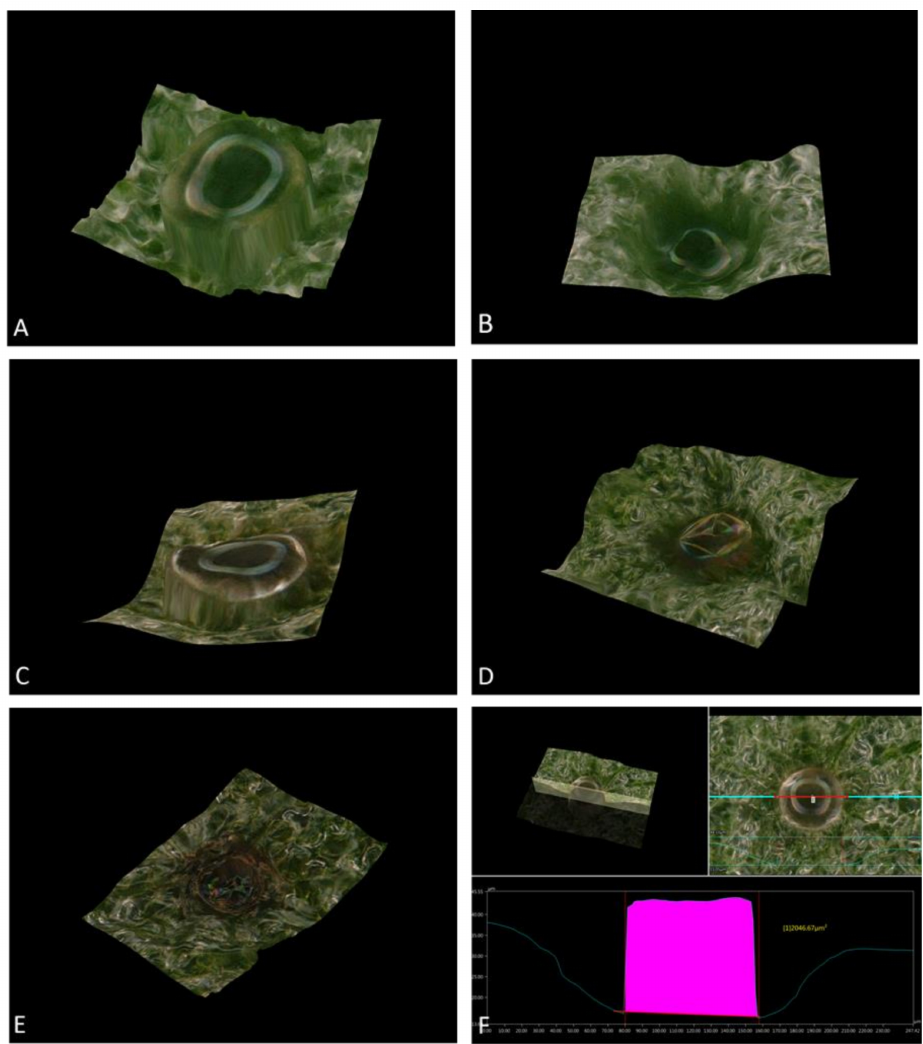
Figure 8. Representative 3-D surface images of different levels of intact and damaged trichomes found in fresh and rehydrated Thai basil leaves. Fully inflated trichome in fresh samples ( A ), damaged trichome in fresh samples ( B ), inflated trichome found in rehydrated samples ( C ), partially inflated trichome in rehydrated samples ( D ), damaged trichomes in rehydrated samples ( E ). Schematic of trichome area measurement using the built-in software of the microscope; the measurement area has a value of 2046.67 µ m 2 ( F ). The magnification of the image during acquisition was 700 × . Table 3. Microscopic evaluation of trichome areas of Thai basil leaves subjected to different pretreat- ments prior to drying with convective air (CD) at 40 ◦ C or under vacuum (VC). The samples were dried to an MR of 0.05. Data are shown as average ± standard deviation of the mean for n = 3. Partially Collapsed Area of Trichomes Samples Drying Method Collapsed Trichomes (%) ( µ m 2 ) Trichomes (%) Fresh CD 3 ± 2 a 0 ± 0 a 2267 ± 89 a Control CD 33 ± 5 b 18 ± 4 cd 1204 ± 133 cd Control-rested CD 27 ± 3 c 19 ± 5 cd 1001 ± 115 cde PEF-rested CD 20 ± 4 d 5 ± 3 b 2218 ± 65 a Control VD 32 ± 5 b 23 ± 3 d 727 ± 80 e Control-rested VD 29 ± 4 c 15 ± 3 c 827 ± 102 de PEF-rested VD 27 ± 5 c 7 ± 3 b 1785 ± 76 b In each column, a different letter superscript indicates statistically significant differences ( p <